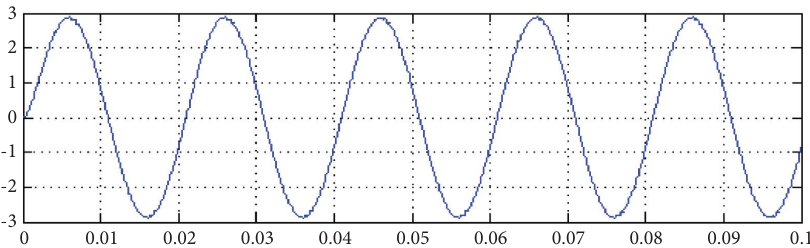
Figure 17: Inductive load current for 9-level